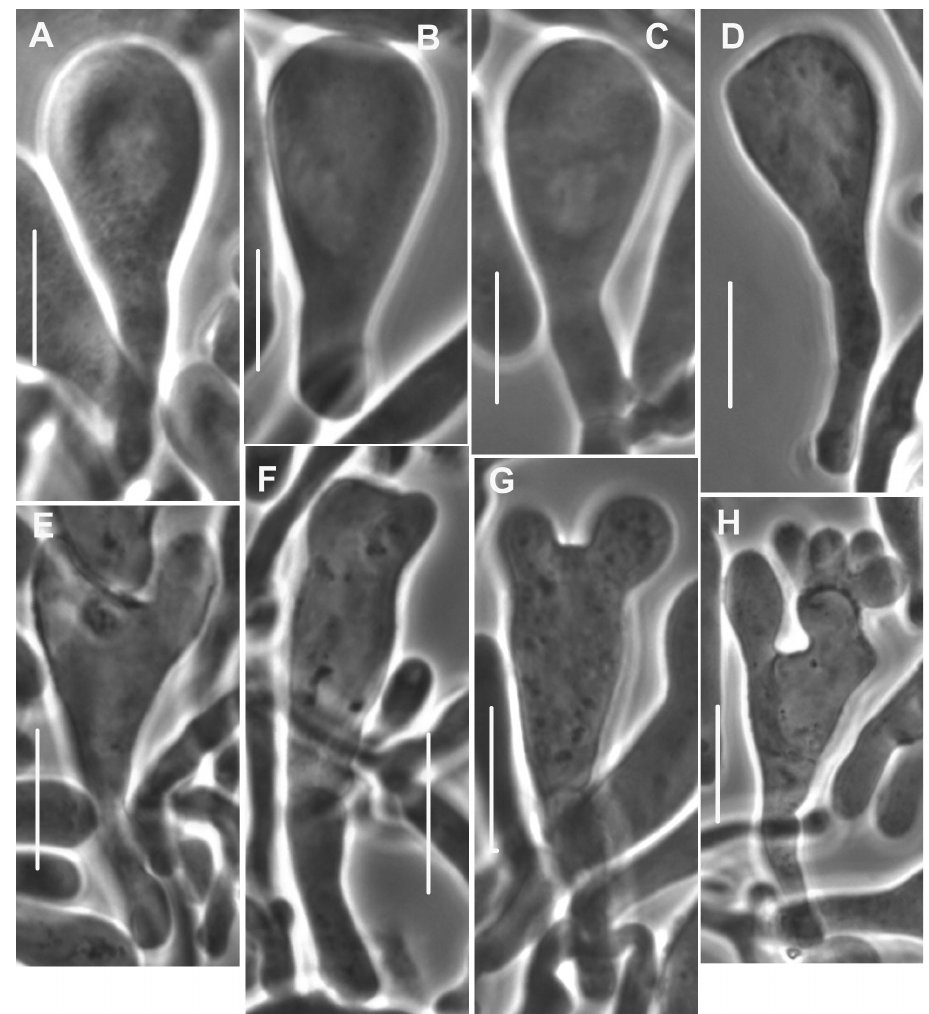
Figure 38. Mycetinis kallioneus . Cheilocystidia. Standard bars = 10 µm. TB 85-209